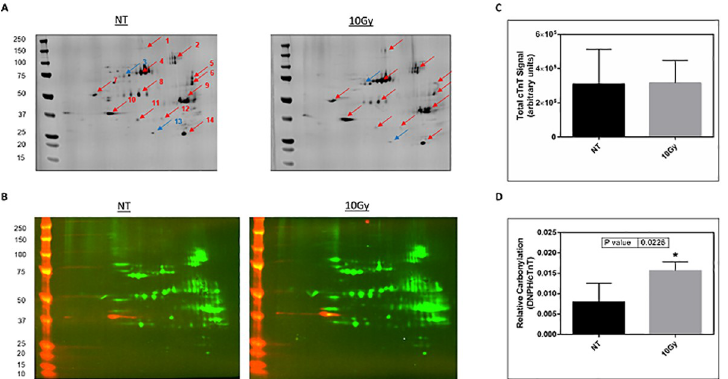
Fig 6. Carbonylation of proteins in male rat heart twenty-four hours after total body irradiation. (A) Two- dimensional fluorescence western blotting of protein carbonylation in no treatment (left) and 10.0Gy total body irradiation (right). Red arrows denote an increase in carbonylation in response to total body irradiation while blue arrows signify a decrease in carbonylation level. See Table 3 for protein identities and fold changes in carbonylation level. (B) Two-color, two-dimensional fluorescence western blotting showing overlap of cTnT (red) and DNP (green) signals. (C) Densitometry quantification of total cTnT protein in the rat heart. (D) Densitometry quantification of relative carbonylation of cTnT protein in the rat heart. Carbonylation signal (DNP) is normalized by cTnT. NT = no treatment; n = 4.